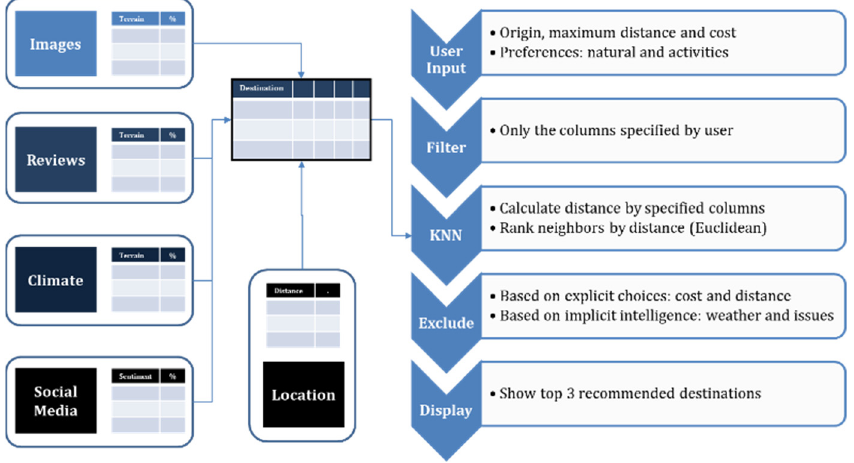
Figure 21. Integration of the augmented big data